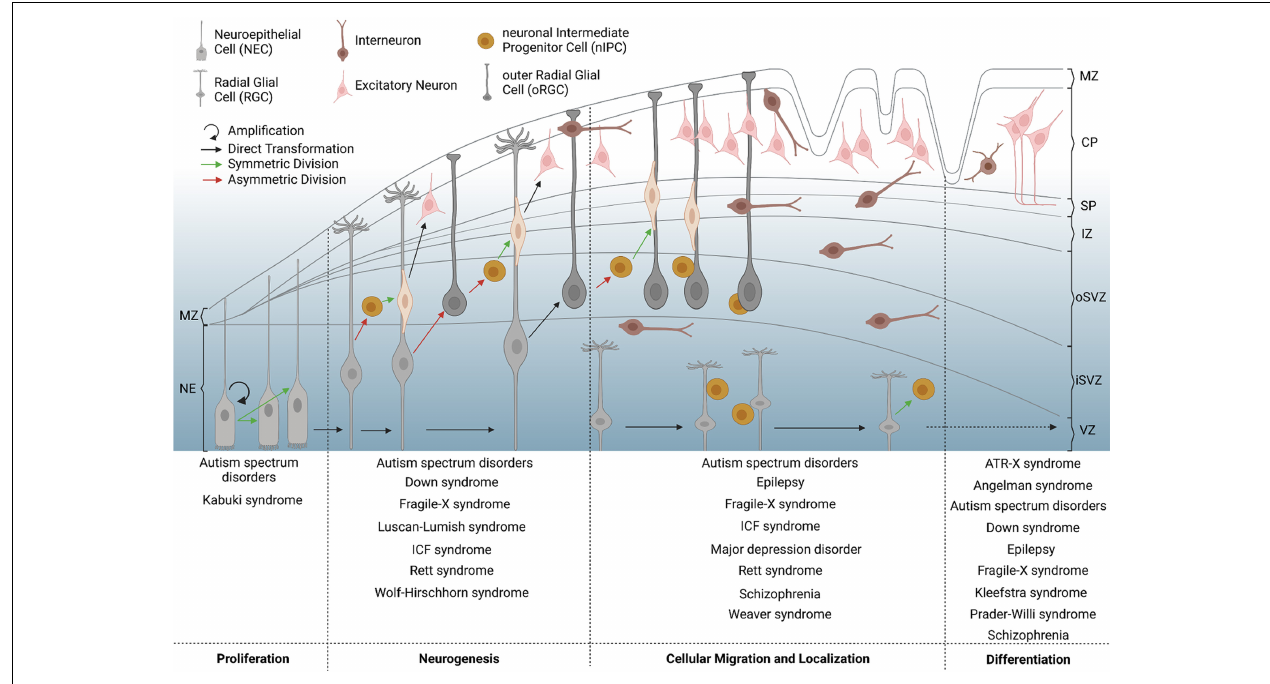
FIGURE 1 | Critical milestones of human corticogenesis and associated NDDs. The human cerebral cortex begins to form by symmetric division of neuroepithelial cells (NECs, bright gray) in the first trimester, which elongate in shape to convert to radial glial cells (RGCs, dark gray). RGCs increase in number, asymmetrically divide and convert to outer radial glial cells (oRGCs) also known as basal RGCs, or give rise to neuronal intermediate progenitor cells (nIPCs), again by asymmetric division. The latter further divide symmetrically to give rise to young excitatory principal neurons (pink), which migrate from the subventricular zone (SVZ) toward the forming cortical plate (CP). Inhibitory interneurons (brown) invade the developing neocortex along the marginal zone (MZ) or the subplate (SP) and SVZ, before they switch to radial migration to enter the cortical plate. Increased progenitor and neuronal numbers as well as rapidly expanding neuronal networks contribute to physical stress, forming the main gyri at the end of the second trimester. At later stages of corticogenesis, intercellular connections begin to form, for which morphological differentiation and defined setting of neuronal proportions are necessary. Failures of corticogenesis are suggested to contribute to various NDDs with respect to the given time point and affected process, which is depicted on the bottom for different examples of diseases. CP = cortical plate; iSVZ = inner subventricular zone; IZ = intermediate zone; MZ = marginal zone; NE = neuroepithelium; oSVZ = outer subventricular zone; SP = subplate; VZ = ventricular